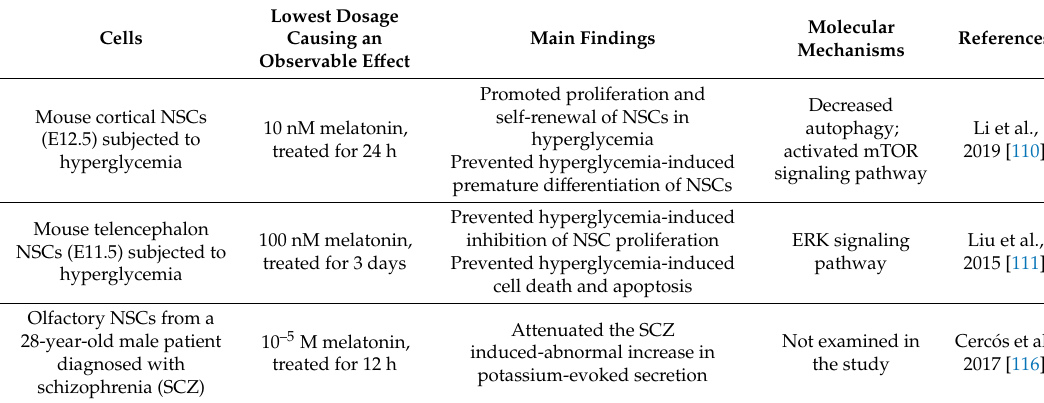
Table 13. Table showing the main findings regarding the e ff ects of melatonin on neurogenesis in other neurogenesis impairment-related diseases and the respective molecular mechanisms in the in vitro studies. Lowest Dosage Cells Causing an Observable E ff